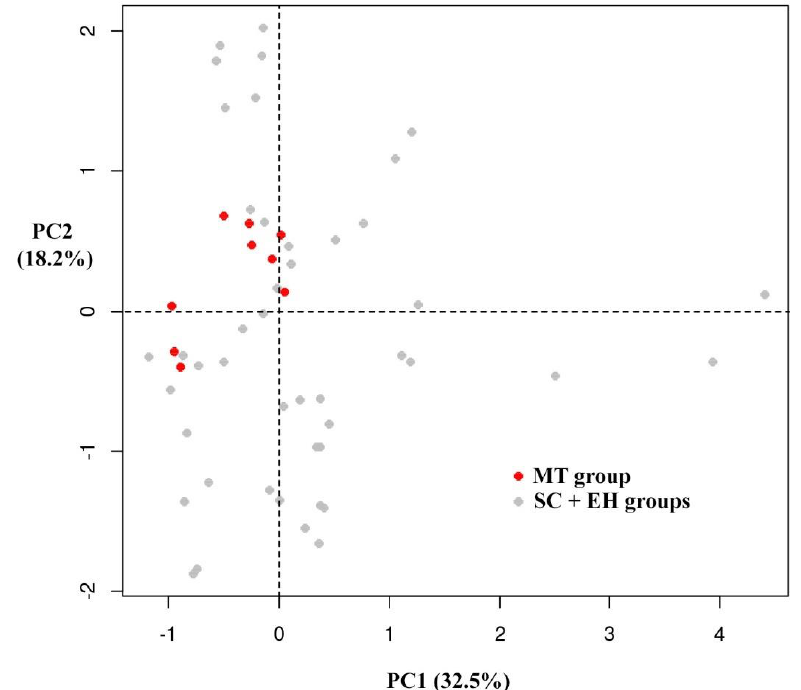
Figure 10. Distribution of the points associated with “Marrone” and “Chestnut” groups in the principal components (PCs) plane. A significant clustering of points associated with MT group ( p < 0.05) is observed in the PCs plane, while the points associated with SC + EH groups are characterised by a significantly dispersed spatial distribution ( p < 0.05) in the same PCs plane. Sweet chestnut = SC. Marrone-type chestnut = MT. Euro-Japanese hybrid = EH.